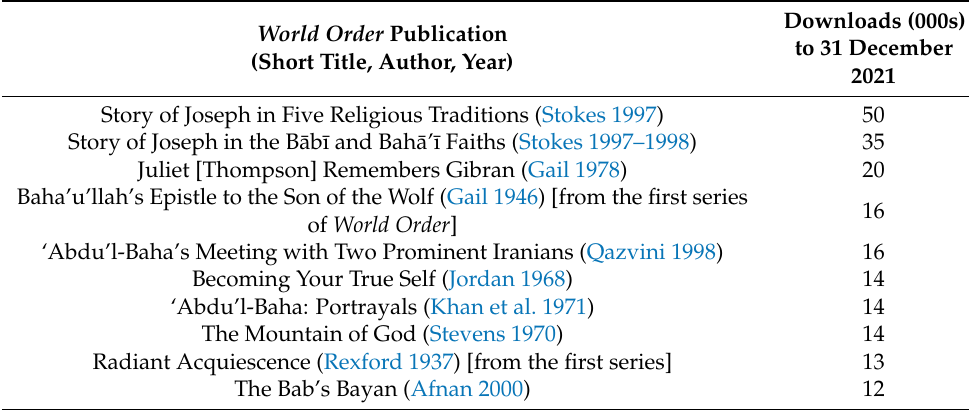
Table 2. Number of downloads for selected World Order articles.